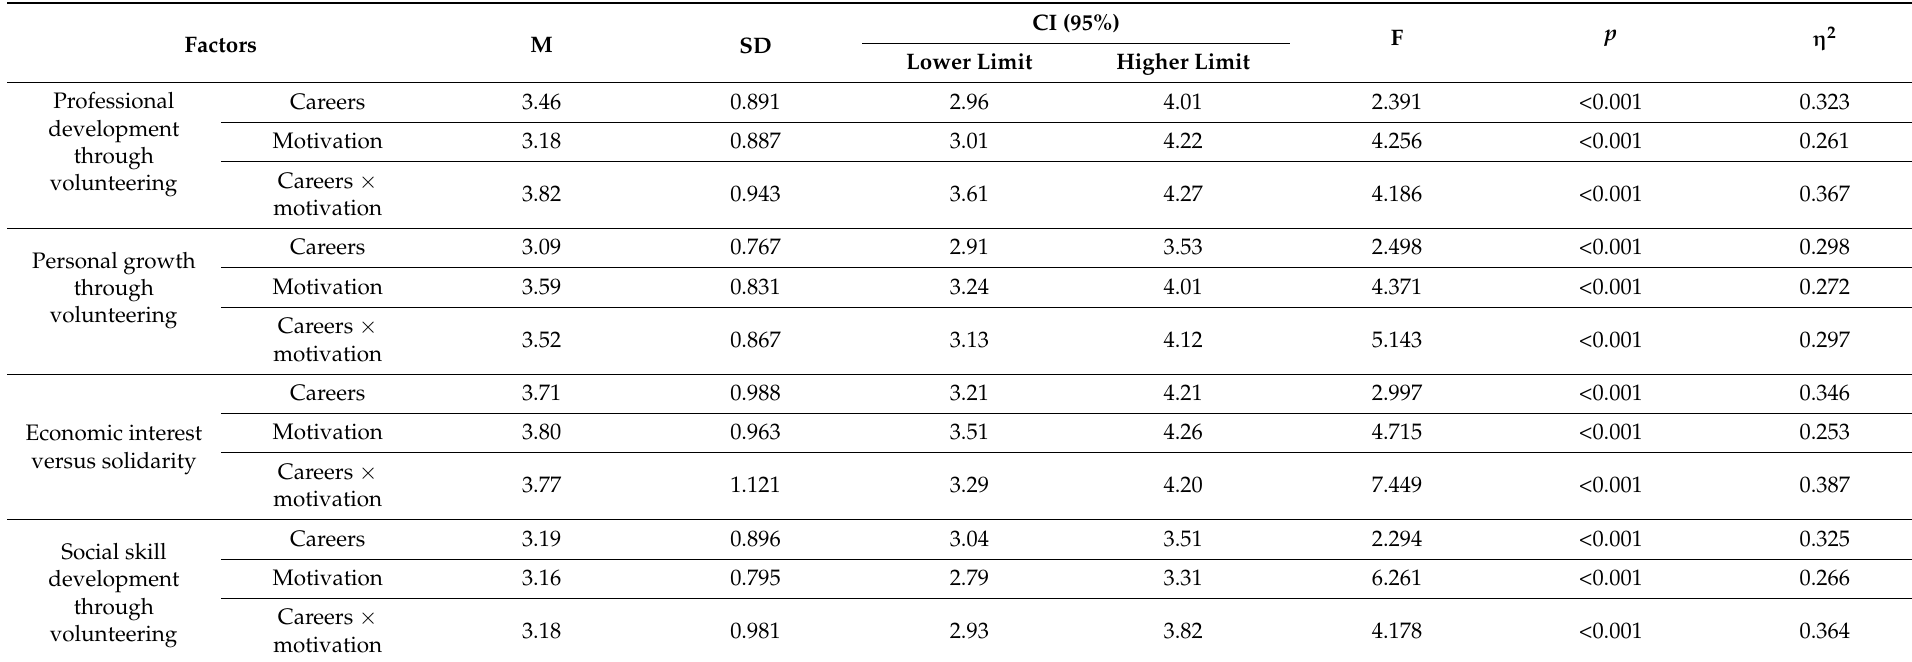
Table 1. Analysis of variance (ANOVA) and effect size ( η 2 ) results for sums of aggregated scales of promotion of social well-being through participation in volunteering using the volunteer motivation and field of study